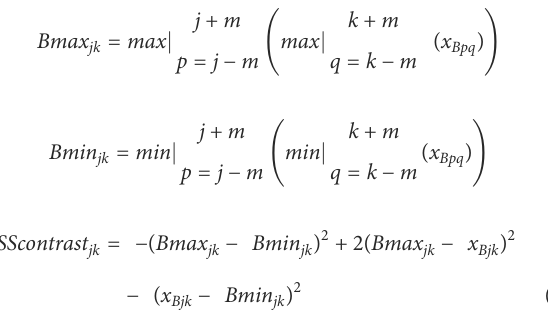
and green:blue ratios respectively to distinguish iridescence for S. scovelli , as described in the previous